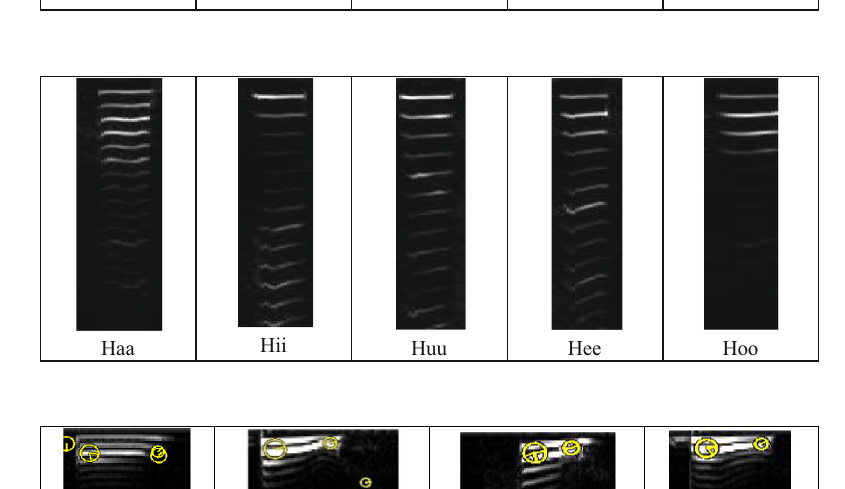
Fig. 4 Spectrogram images of five utterances in the JVPD from a speaker